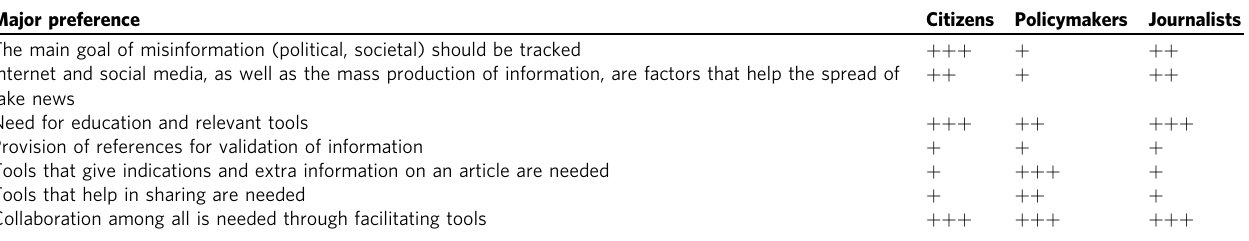
Table 1 Major preferences of various stakeholders regarding how to address misinformation in the three case countries (Sweden, Greece and